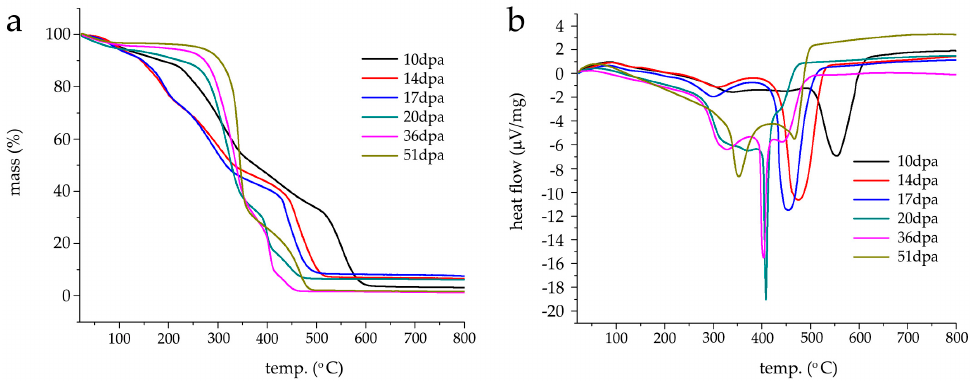
Figure 4. Analysis of raw/washed G. hirsutum fibers harvested at different stages of development (10, 14, 17, 20, 36 and 51 dpa). The fibers were removed without stretching, washed in distilled water prior to air-drying at room temperature and kept in controlled humidity atmosphere (52% RH). ( a ) thermogravimetric (TGA) profiles shows the typical three regions, corresponding to water and volatile non-cellulosic (60–150 °C), decomposition of non-cellulosic (150–250 °C), and cellulosic components/char decomposition (250–500 °C); ( b ) Differential scanning calorimetry (DSC) analysis shows a major endothermic band shifting towards lower temperatures as fruit development proceeds. At 51 dpa, this band is centered at 352 °C corresponding to cellulose thermal decomposition and another band centered at 466 °C is assigned to char crystallization processes.